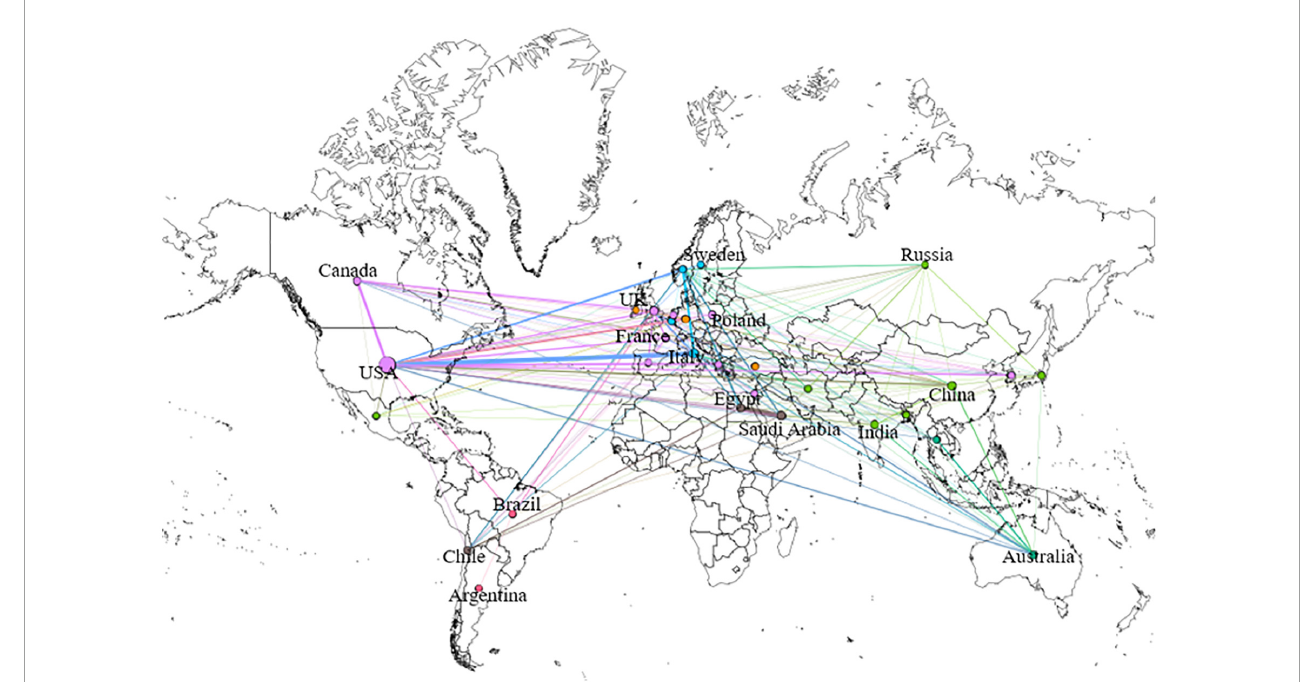
FIGURE3 Geography map of national cooperative: The size of the circles shows the number of publications by country. There is a connection between countries, which means that there is cooperation between the two countries. The same color of the wires means that these countries form academic groups.